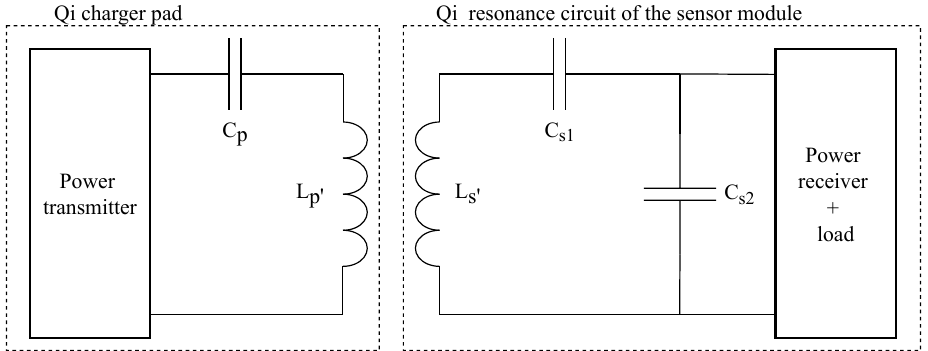
Figure 7. Wireless Power Transfer (WPT) setup. A Qi power transmitter with a Qi power receiver and load, based on LC resonant circuits.